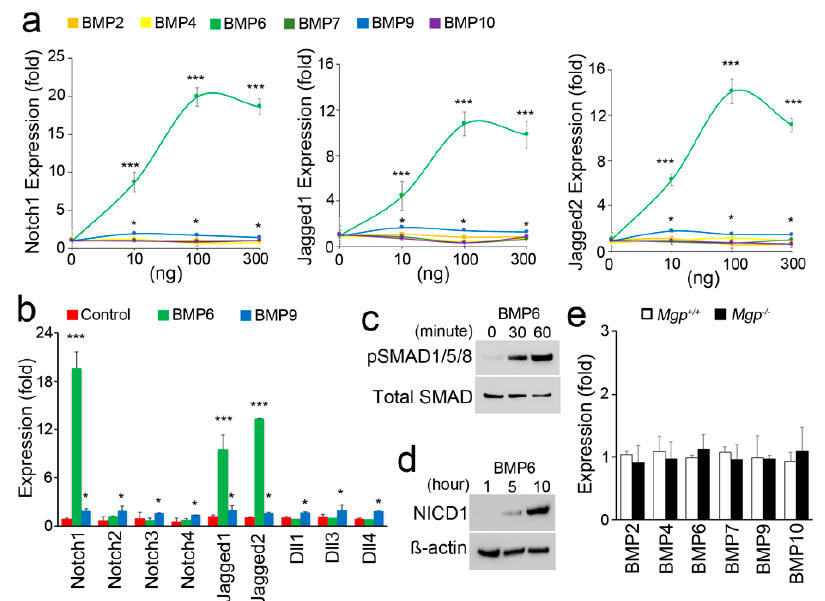
Figure 2. Bone morphogenetic protein 6 (BMP6) induces Notch1 and Jagged1 and 2 in cerebral ECs. ( a ) Expression of Notch1 and Jagged1 and 2 in human brain microvascular cells (HBMECs) treated with different doses of BMP2, 4, 6, 7, 9, or 10. ( b ) Expression of components of the Notch pathway in HBMECs treated with BMP6 (100 ng/mL) and BMP9 (10 ng/mL). ( c ) Immunoblotting of pSMAD1/5/8 in HBMECs at 0, 30, and 60 min of treatment with BMP6. ( d ) Immunoblotting of Notch1 intracellular domain (NICD1) in HBMECs at 1, 5, and 10 h of treatment with BMP6. ( e ) Expression of BMPs in cerebra (n = 5). * p < 0.05; *** p < 0.001. Cells 2019 , 8 , x